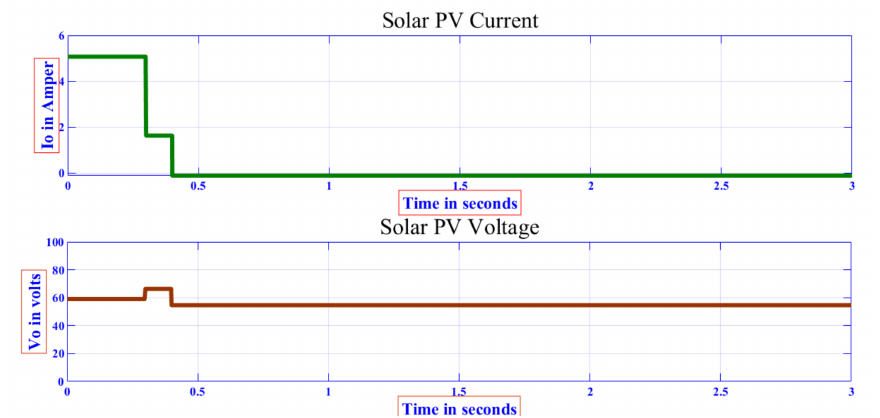
Figure 10. Output of the solar PV system.